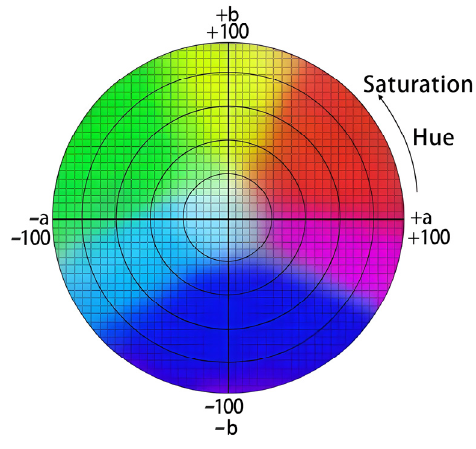
Figure 2. CIELAB color coordinate system [26].